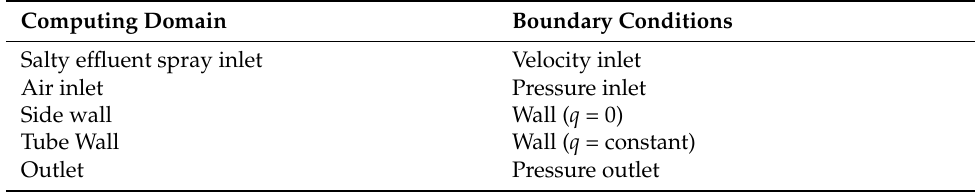
Table 2. Boundary conditions of the computing domain.